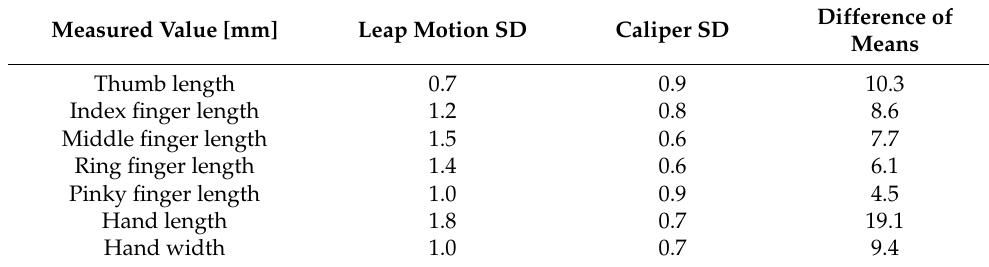
Table 1. Standard deviations (SD) and Difference of Means of length